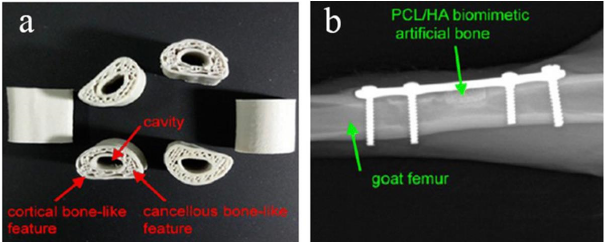
Figure 5. ( a ) S tructure diagram of PCL/HA stent, ( b ) CT image of implantation in vivo